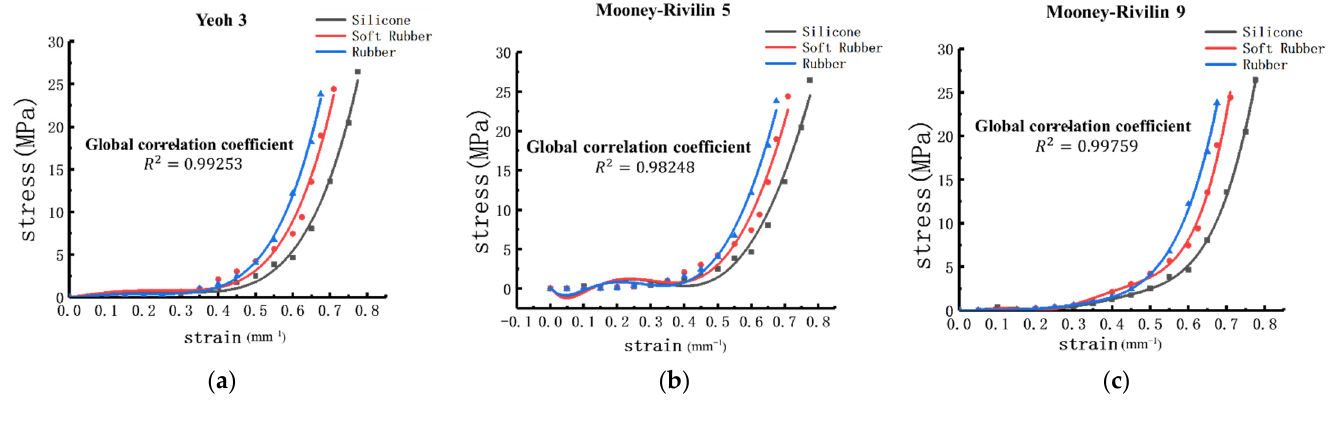
Figure 5. Stress–strain fitting curves of three models: ( a ) Yeoh3; ( b ) Mooney–Rivilin5; ( c ) Mooney–